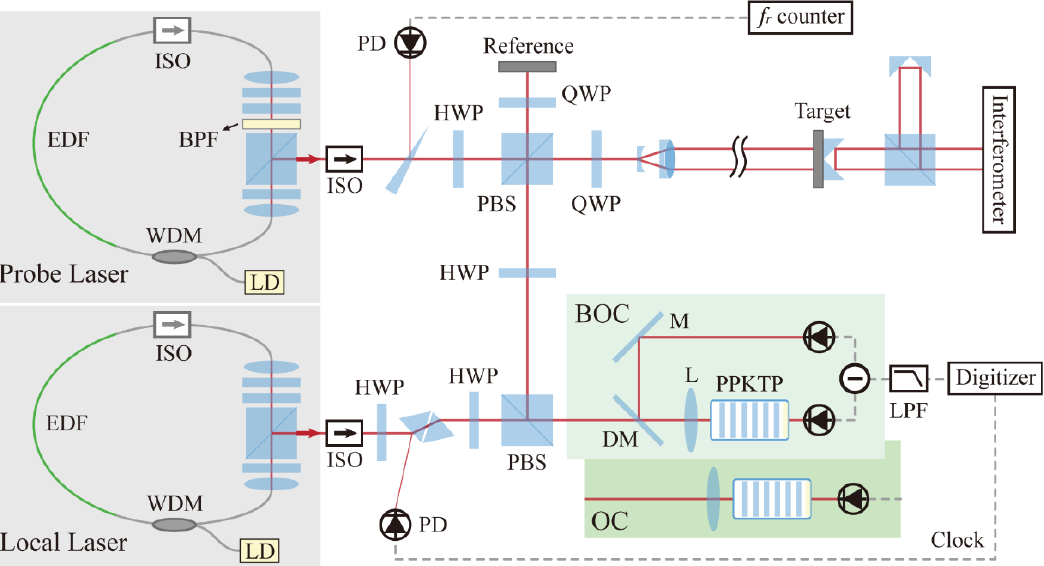
Figure 6. Experimental setup of absolute distance measurement using nonlinear ASOPS. BPF, optical bandpass filter; DM, dichroic mirror; HWP, half-wave plate; ISO, isolator; LPF, low pass filter; M, mirror; PBS, polarization beam splitter; PD, photodetector; QWP, quarter-wave plate; WDM, wavelength division multiplexer.